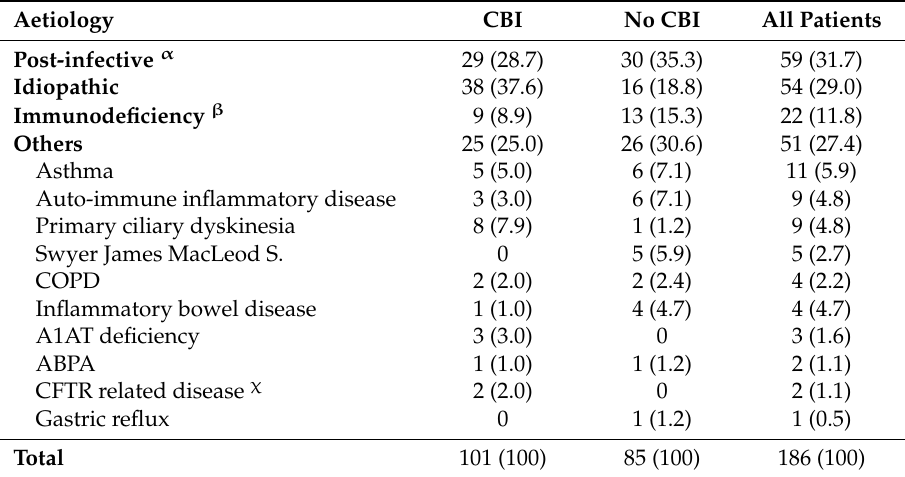
Table 1. Bronchiectasis aetiology. CBI, chronic bacterial infections.